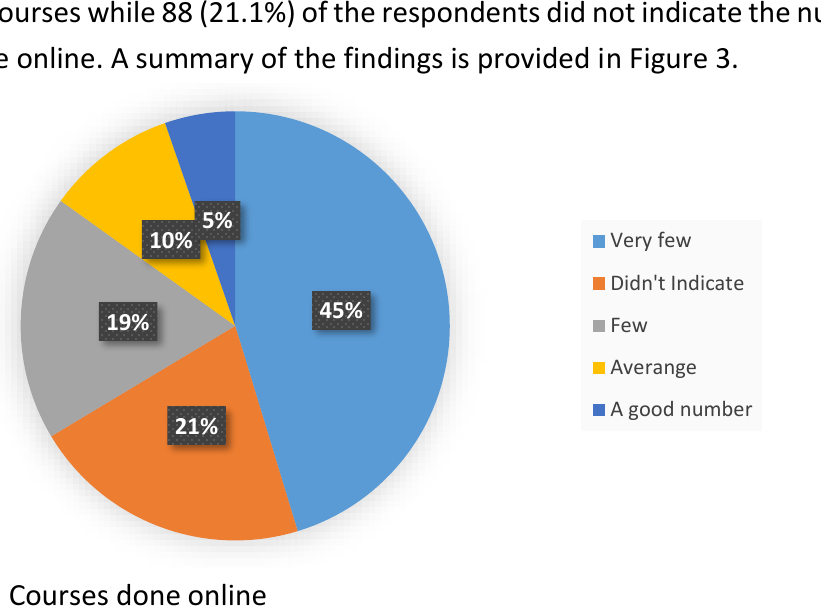
Figure 3. Courses done